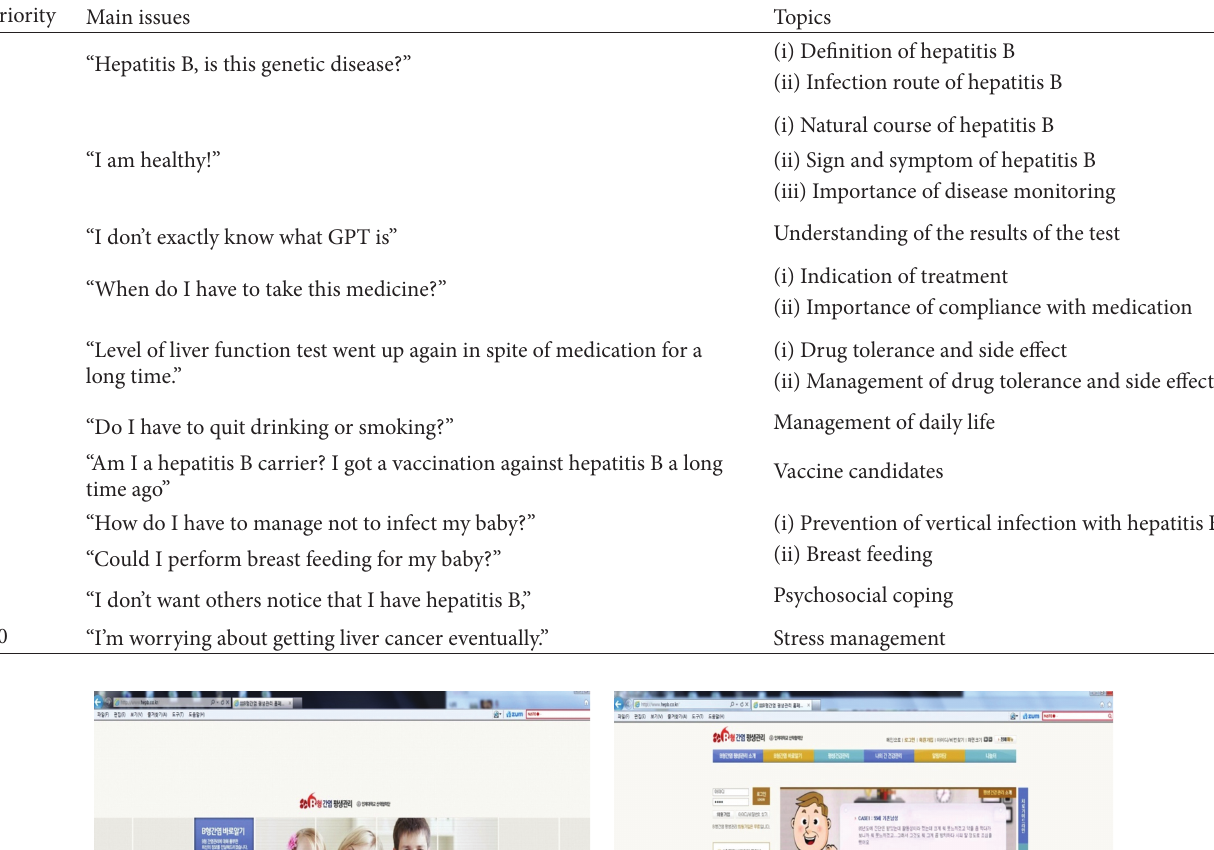
T 1: Main issues of program for promoting self-management of patients with hepatitis B.